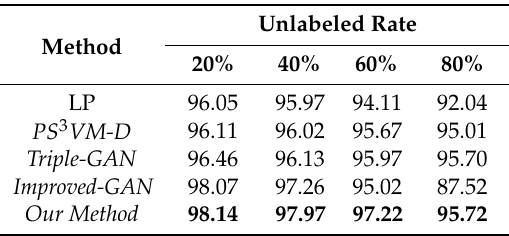
Table 6. Recognition accuracy (%) of LP, PS 3 VM-D, Triple-GAN, Improved-GAN, and our method with different unlabeled